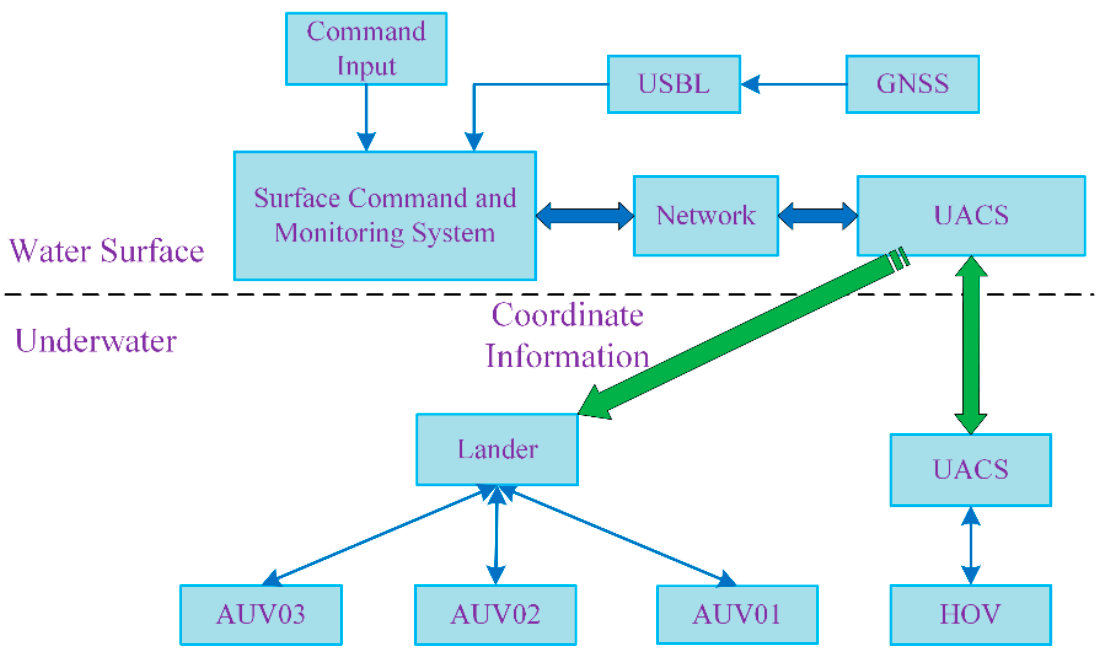
Figure 9. Information flow of a cooperative operation based on a lander.